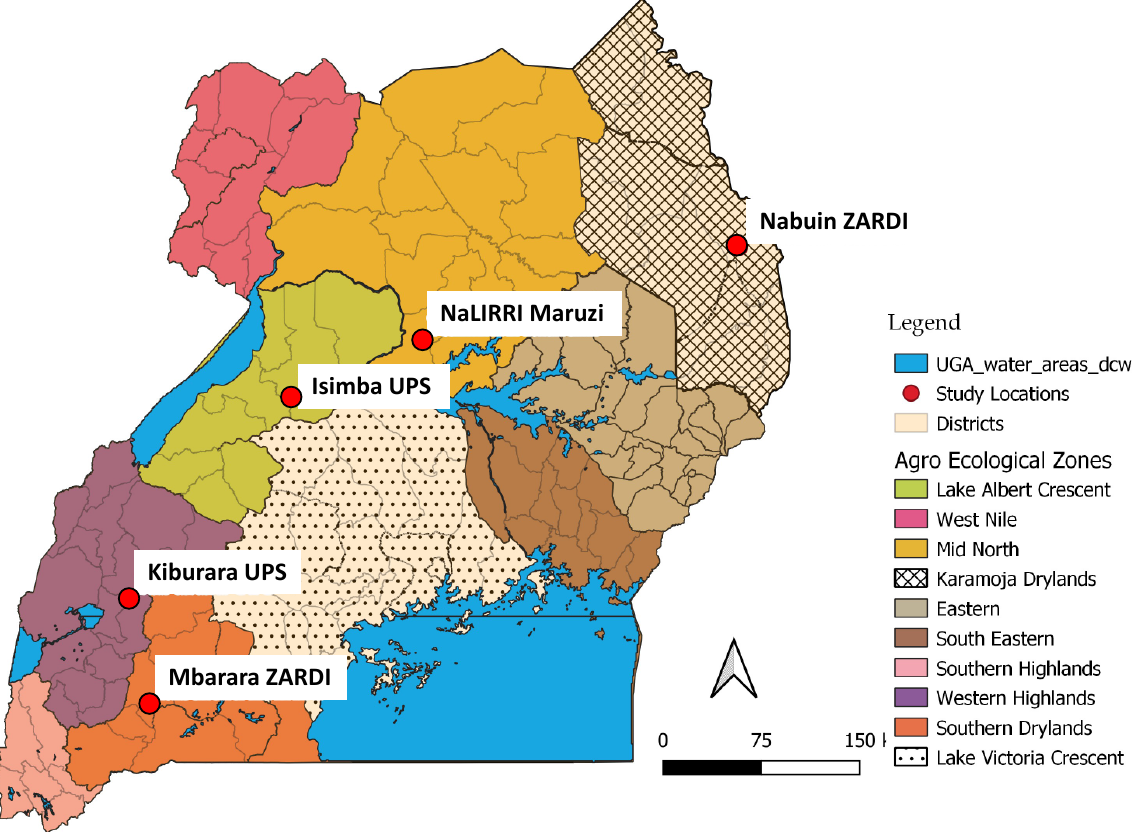
Figure 1. Uganda agroecological zones with locations of the trial coordination center and experimental cattle sites.